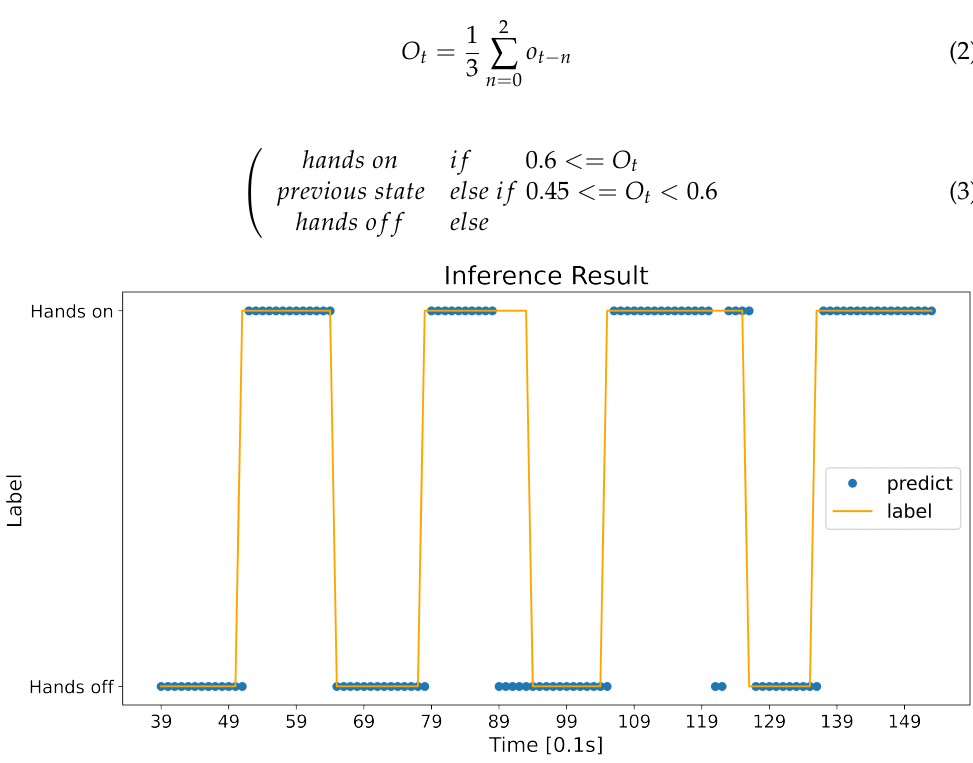
Figure 6. Raw predictions of a